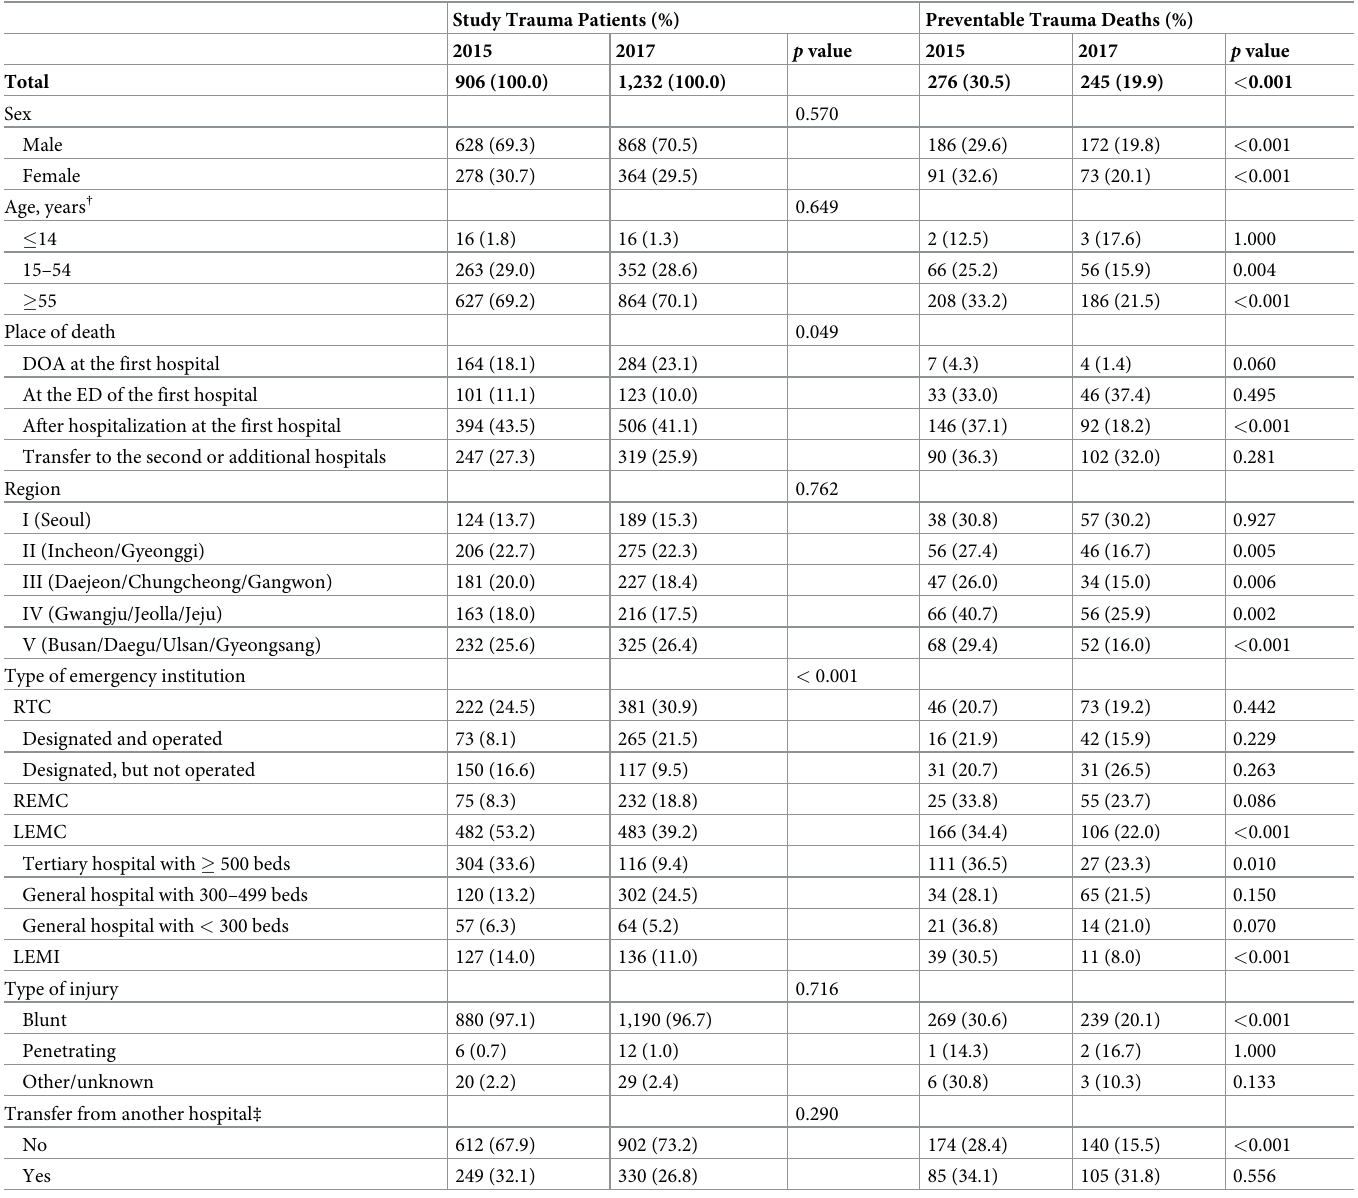
Table 1. Comparison of basic characteristics of the study patients and the preventable trauma death rate �